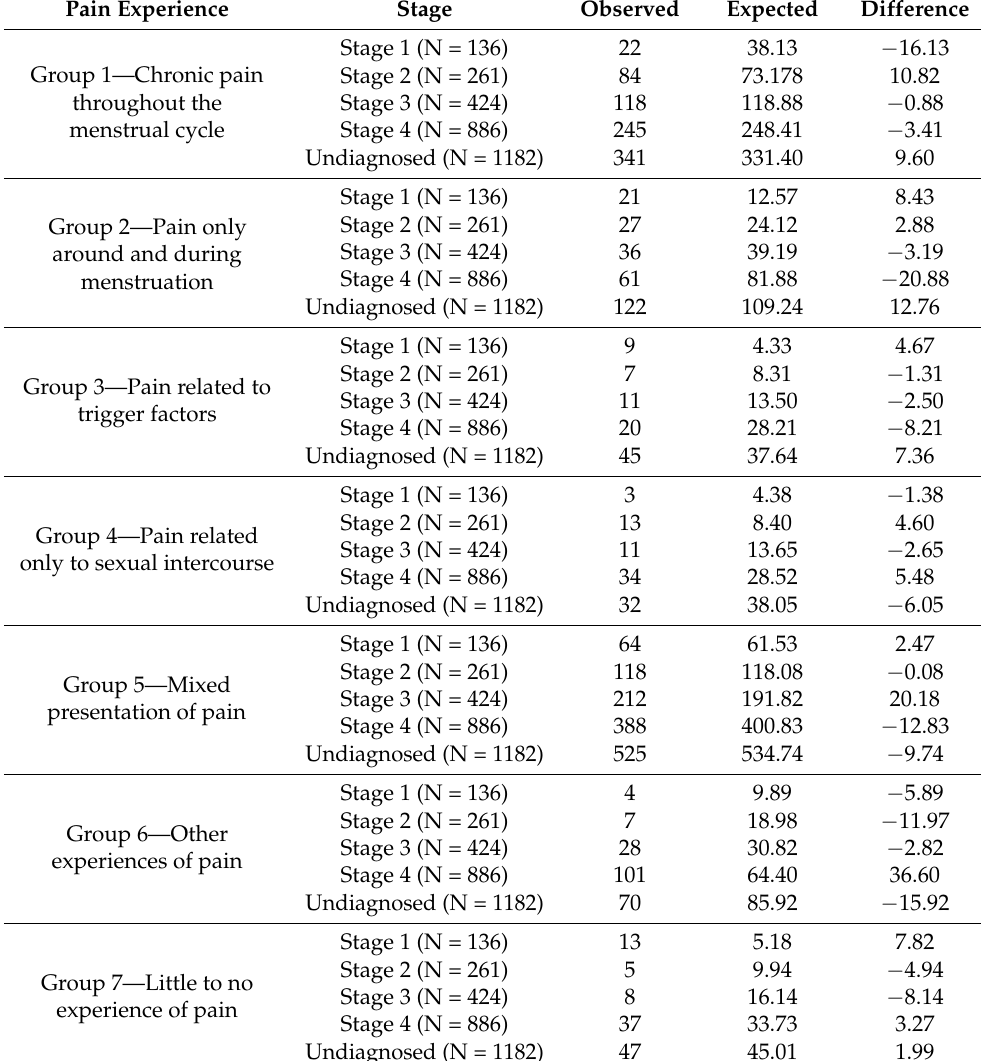
Table 6. Observed distribution of pain minus expected distribution of pain in relation to stage by participants at the time of the completion of the